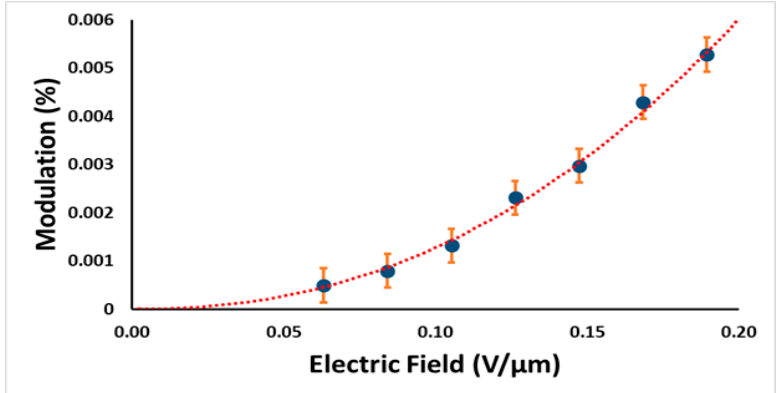
Figure 3. Electroabsorption modulation in gold nanoparticles within glass for different applied electric fields. Particle diameter ~15 nm. Interaction length ~3 cm.